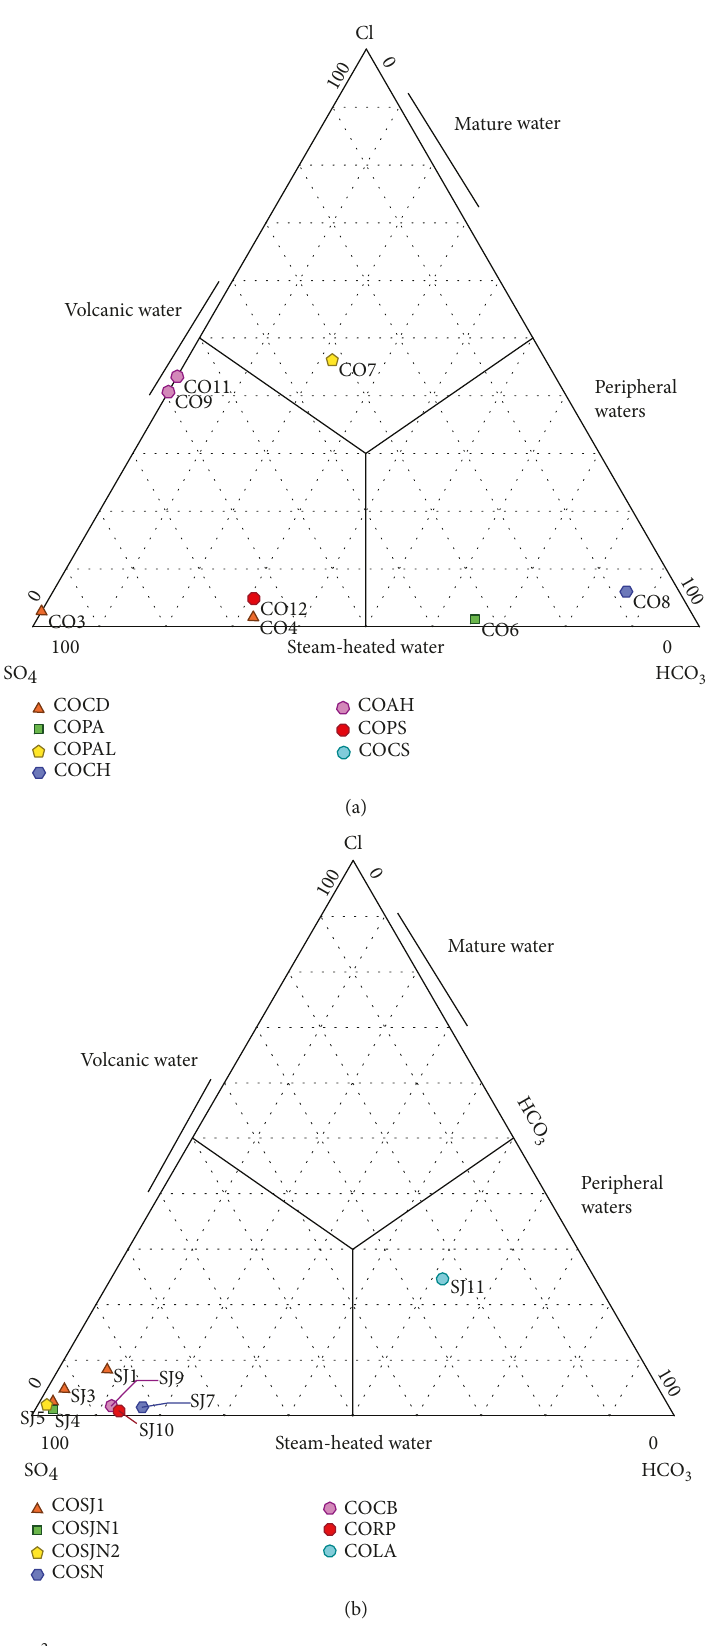
− ternary diagram for the (a) Coconuco sector and the (b) San Juan sector 2 − ‐ HCO Figure 5: Cl − ‐ SO 4 3